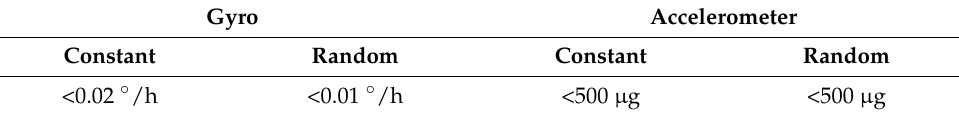
Figure 7. Equipment and platforms in the boat. Table 2. Sensor